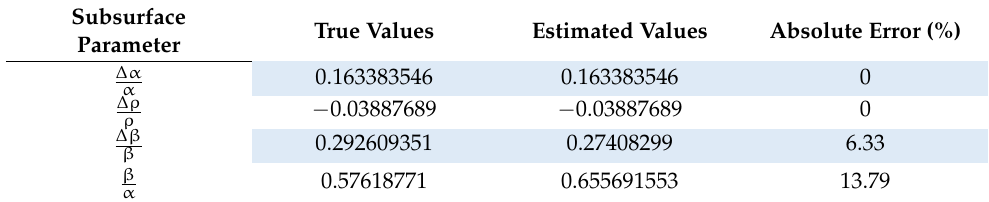
Table 8. Subsurface parameter values and absolute errors for CTP 88 in the oil